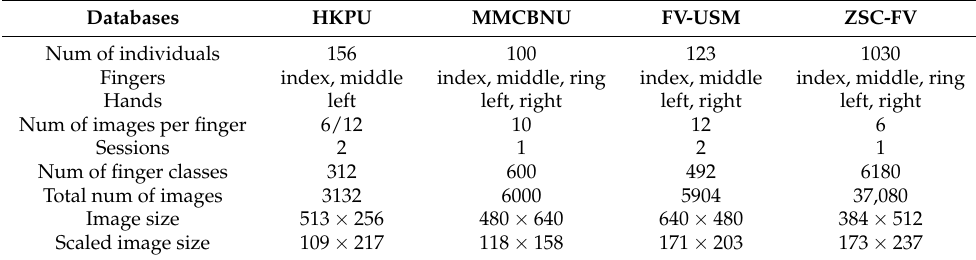
Table 1. Details of four finger vein